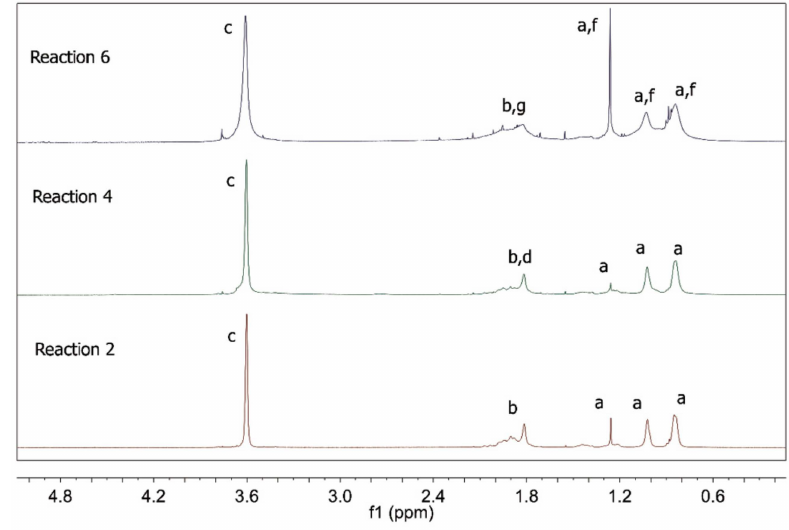
Figure 8. 1 H NMR spectra of polymer products of R2, R4 and